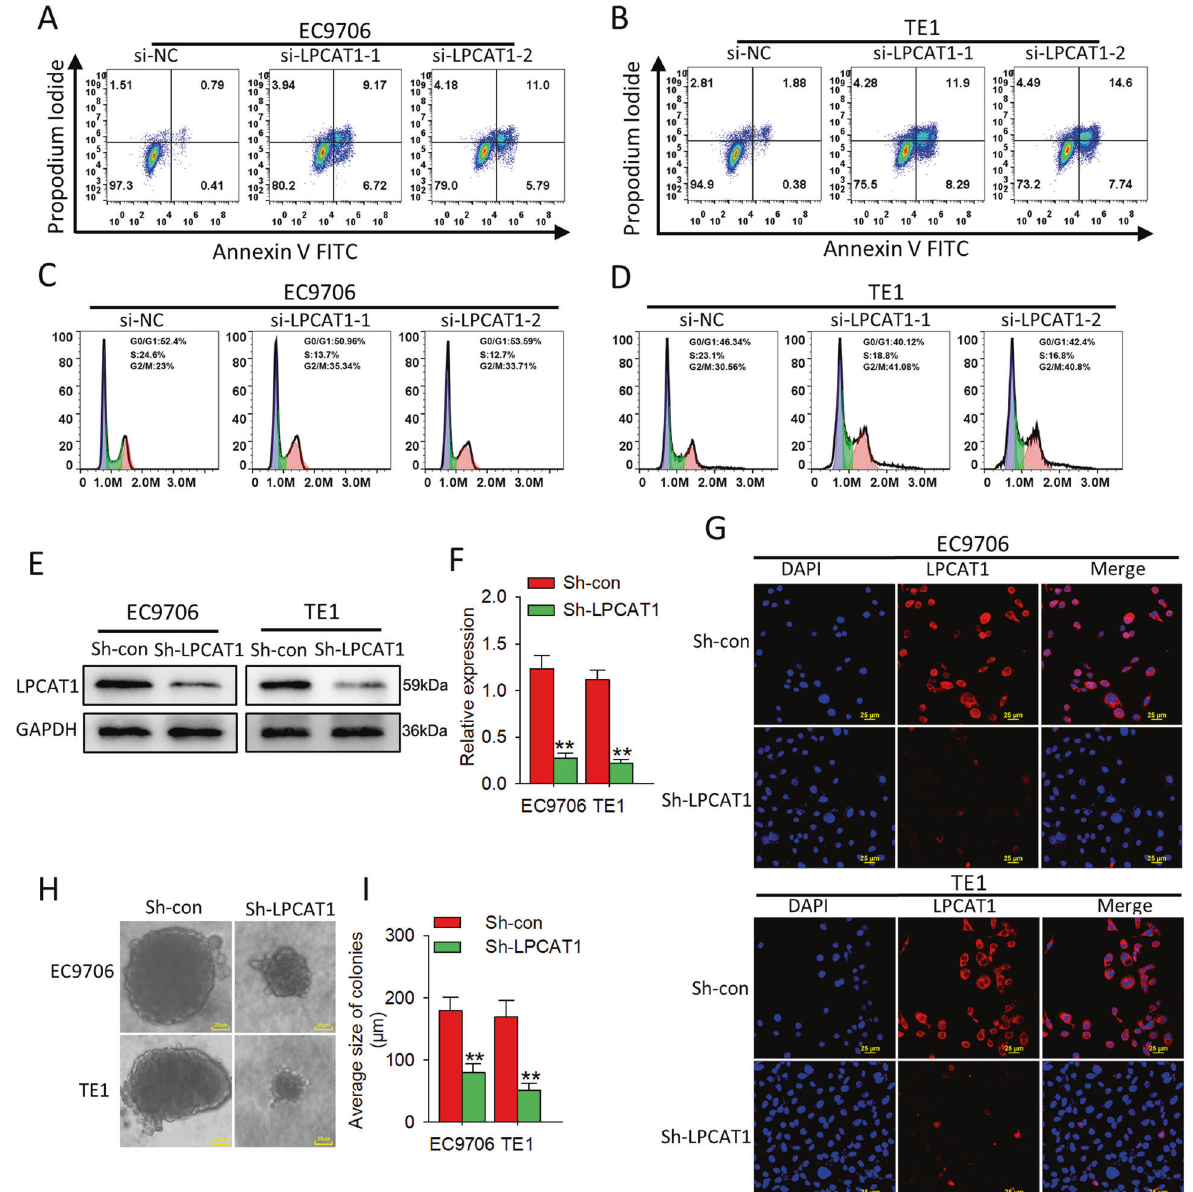
Fig. 3 LPCAT1 inhibits apoptosis of ESCC cells and promotes cell cycle progression and anoikis resistance. A , B Annexin V-FITC/PI double staining was used to assess the apoptosis of EC9706 cells and TE1 cells after transfection with si-NC and si-LPCAT1. C , D DNA content of EC9706 cells and TE1 was analyzed by fl ow cytometry after transfection with si-NC and si-LPCAT1. E , F EC9706 cells and TE1 cells were stably transfected with LPCAT1 lentivirus. G Confocal assay was performed to assess the expression of LPCAT1 in EC9706 cells and TE1 cells. H , I Colony-formation assay was performed to assess EC9706 cells and TE1 cells for anoikis resistance. The average size of colonies was calculated as mean ± S.D. ** P < 0.01 (unpaired t test). Data are from three independent